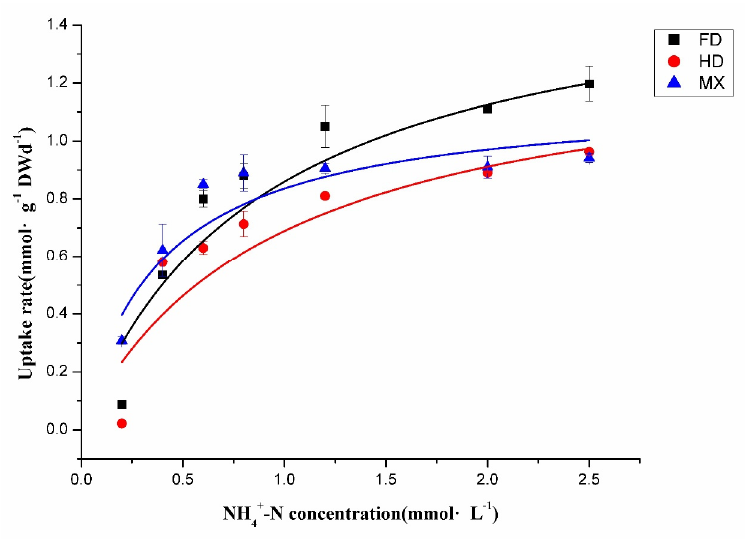
Figure 4. Kinetic absorption curve of NH 4 + –N in roots of three different tea plant cultivars. The data are presented as six biological replicates ± SD.